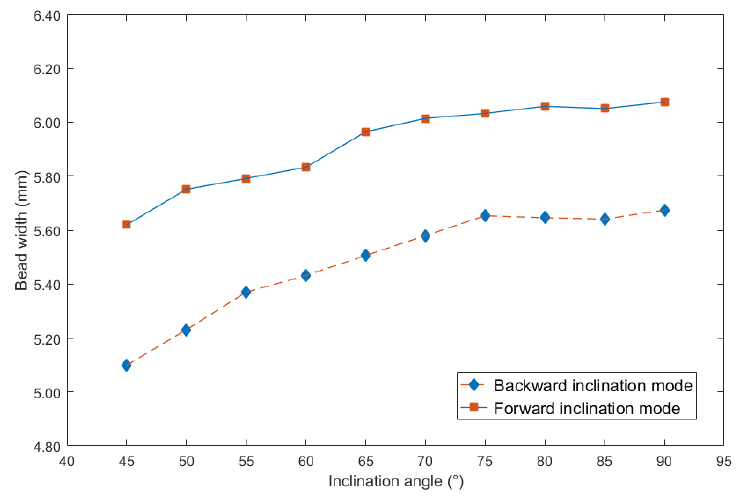
Figure 4. Curve between inclination angle and bead width.